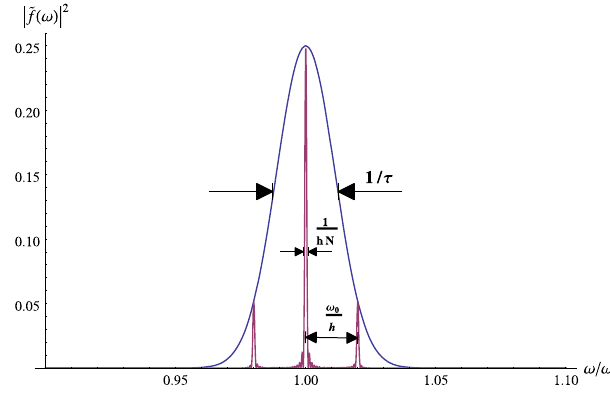
FIG. 3. Power spectrum of a short pulse train demonstrating the relationship between the different scales. The parameters here are N ¼ 10 , h ¼ 50 , and τ ¼ 10 π = ω 0 . Given the artificially small N to illustrate the subharmonic width, some small sidebands are